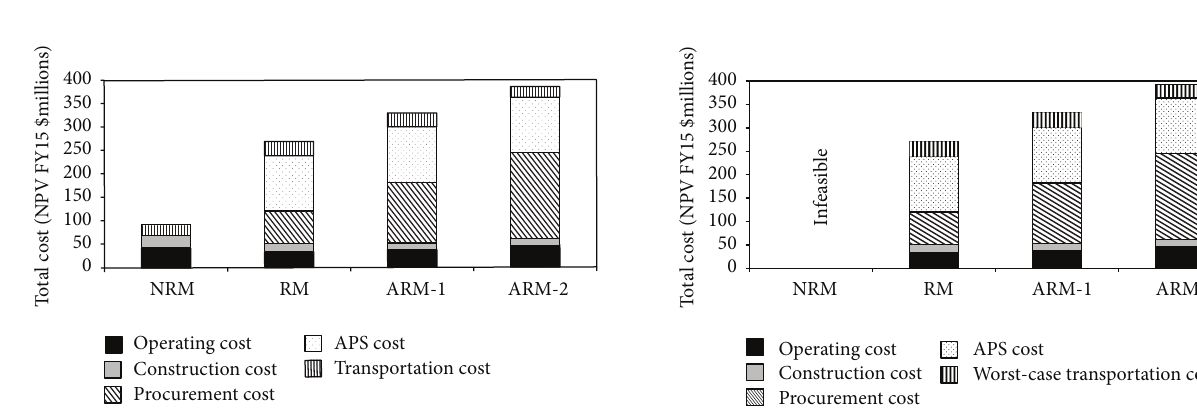
Figure 4: Costs, assuming no loss of access occurs. Figure 5: Costs, assuming loss of access to a single